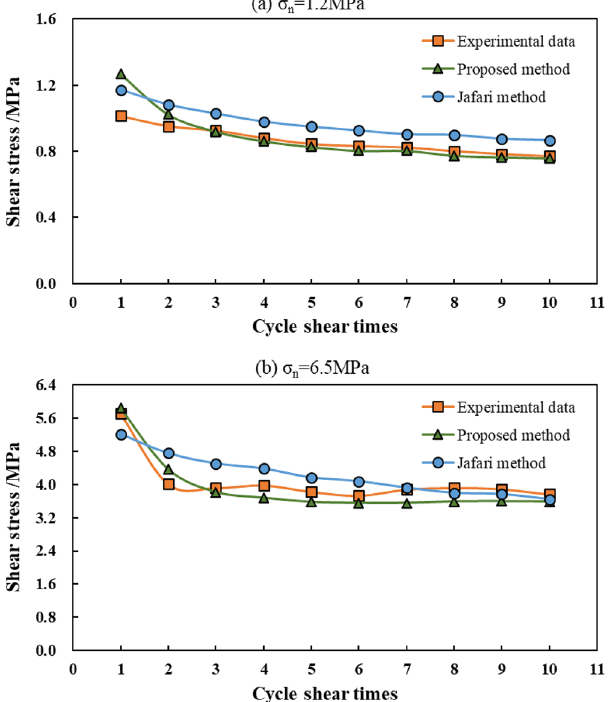
Figure 9. Comparison between the results of proposed method in this study, Jafari et al. 5 proposed method, and the